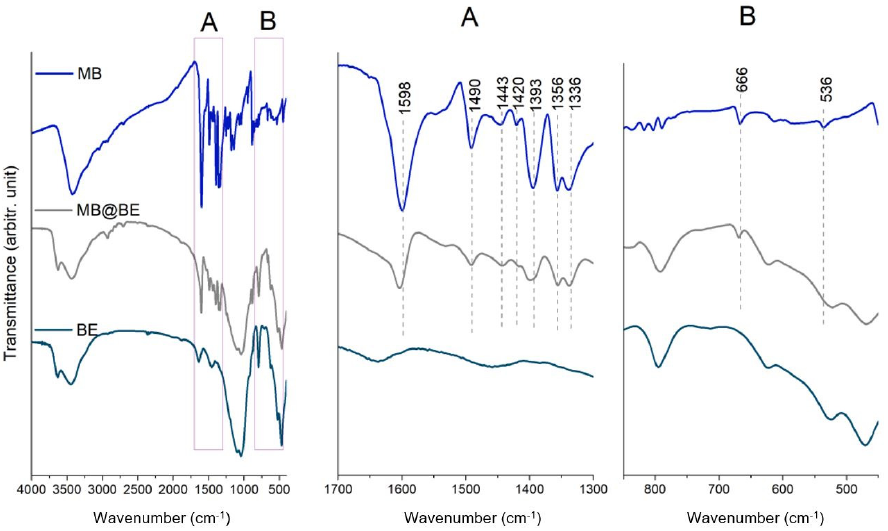
Figure 3. FTIR spectra of MB and BE adsorbent before and after MB adsorption (MB@BE).